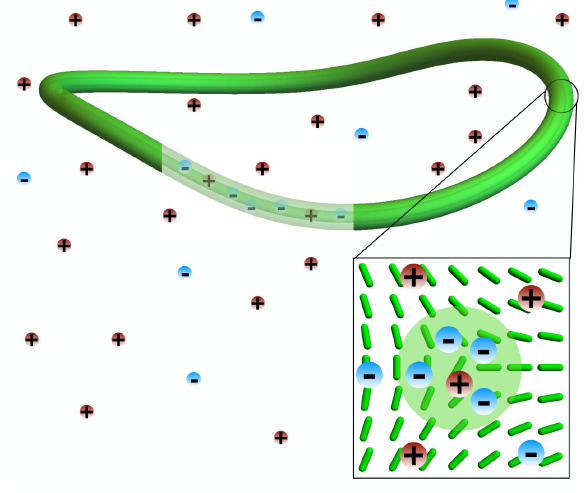
FIG. 1. Scheme of a nematic topological defect loop, with the isotropic core visualized in green, where positive and negative ions redistribute according to the local order parameter, director field, and flexoelectric